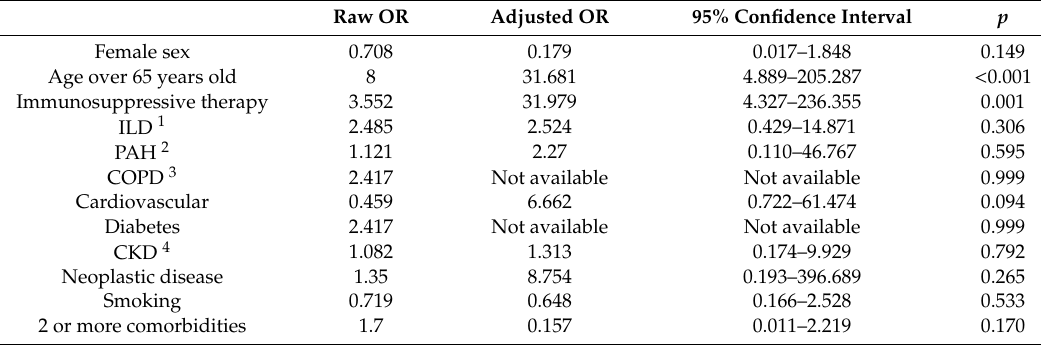
Table 4. Raw and adjusted odds ratios (ORs) on each factor evaluated for flu vaccination. Raw OR Adjusted OR